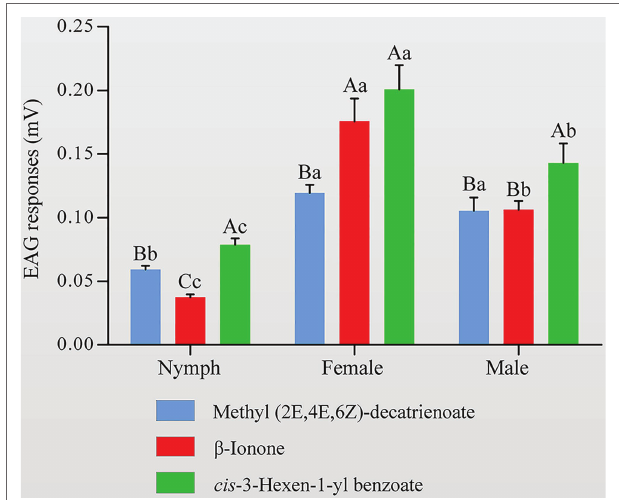
FIGURE 6 | Electroantennography (EAG) activity of Halyomorpha halys antennae to different ligands of HhalCSP15. Different uppercase letters indicate significant differences among different chemicals, and different lowercase letters indicate significant differences among nymphs, females, and males ( p <